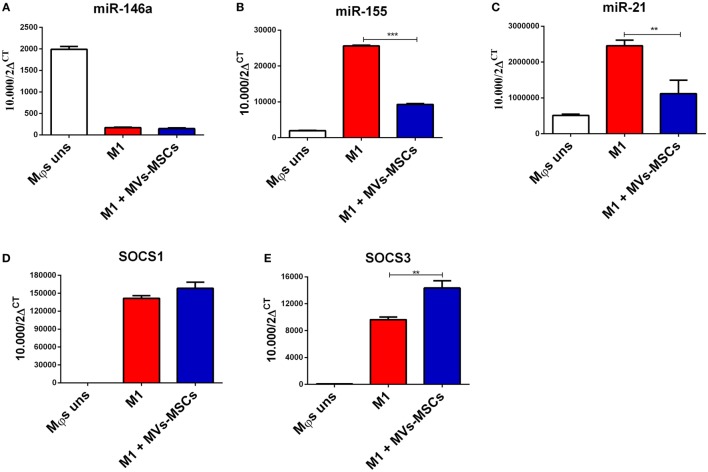
General pro-inflammatory miRNA profile and expression of its predicted target in M1-Mϕs treated or not with MVs-MSCs. (A) miR146a expression; (B) miR-155 expression; (C) miR-21 expression; (D) SOCS1 transcriptional level; and (E) SOCS3 transcriptional level. The MVs-MSCs treatment downregulates the inflammatory miRNAs expression, as well as of its predicted targets genes in M1-Mϕs (*P < 0.05, **P < 0.01, ***P < 0.001).